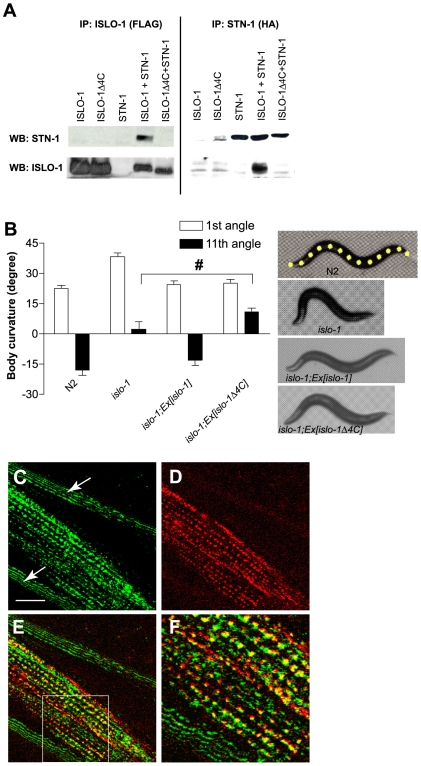
ISLO-1 interacts with the dystrophin complex through STN-1.(A) Co-Immunoprecipitation of ISLO-154-end and STN-1. ISLO-154-end (or ISLO-1Δ4C54-354 lacking the concensus type I PDZ interaction sequence) and STN-1 were tagged with FLAG and HA epitope, respectively. These constructs were used for transient transfection in HEK 293 cells. Immunoprecipitation (IP) and Western blot analysis (WB) was performed with FLAG or HA antibody. (B) The first and eleventh curvature angles obtained from wild-type, islo-1 and islo-1 transgenic animals. For the first angle, N2 versus islo-1, islo-1 versus islo-1;Ex[islo-1] and islo-1 versus islo-1;Ex[islo-1Δ4C] are significantly different from each other (P<0.05). For the 11th angle, N2 versus islo-1 and islo-1 versus islo-1;Ex[islo-1] are significantly different from each other (P<0.05). Number sign indicates no significant difference from islo-1 for tail angle value. Error bars, SEM. Representative photos show whole-body posture of animals on right including the 13 yellow midline points superimposed on the image of a wild-type animal. (C–F) Integrated transgenes of GFP-tagged sgca-1 (C) and mCherry-tagged islo-1 (D) are shown in the islo-1;sgca-1 double mutant. Arrows denote the edge of cuticle. (E) Merged image of C and D. (F) Enlarged image of inset in E.